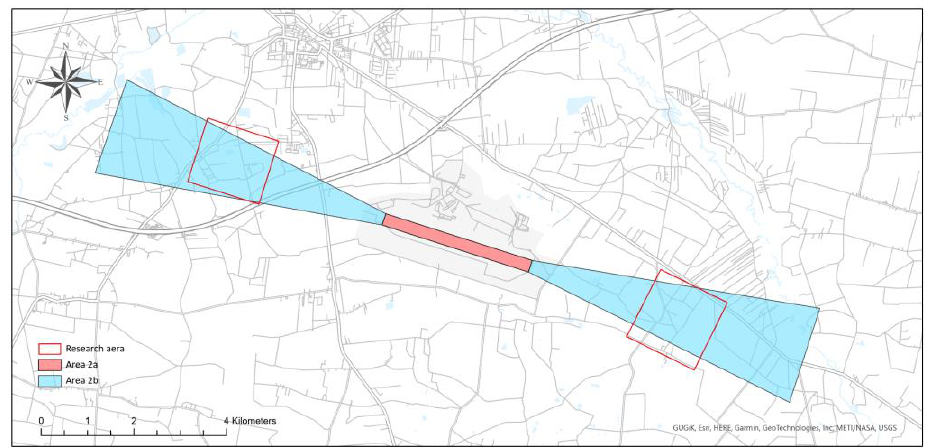
Figure 9. Test areas —Łask airport.